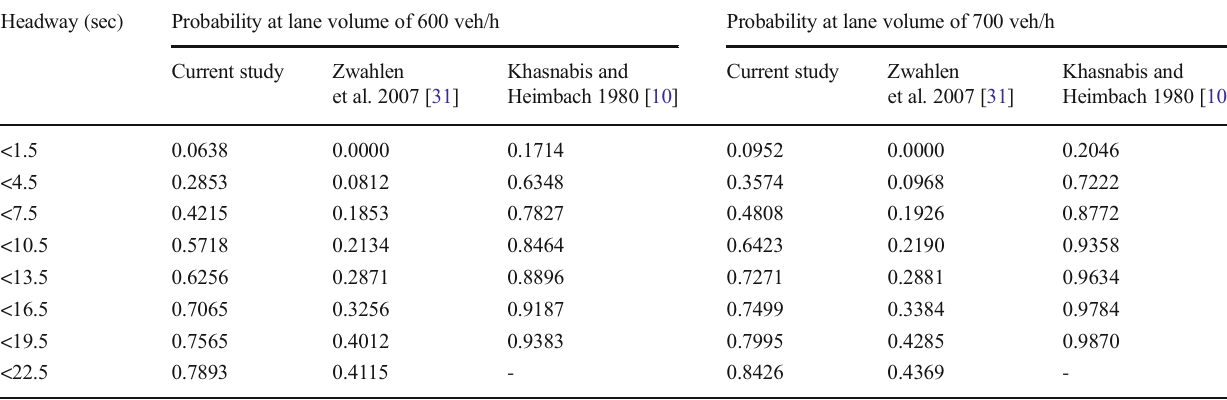
andSouth(pilotstudy)bound traffic; c East (nomograph)and North(pilot study) bound traffic and d East (nomograph) and South (pilot study) bound